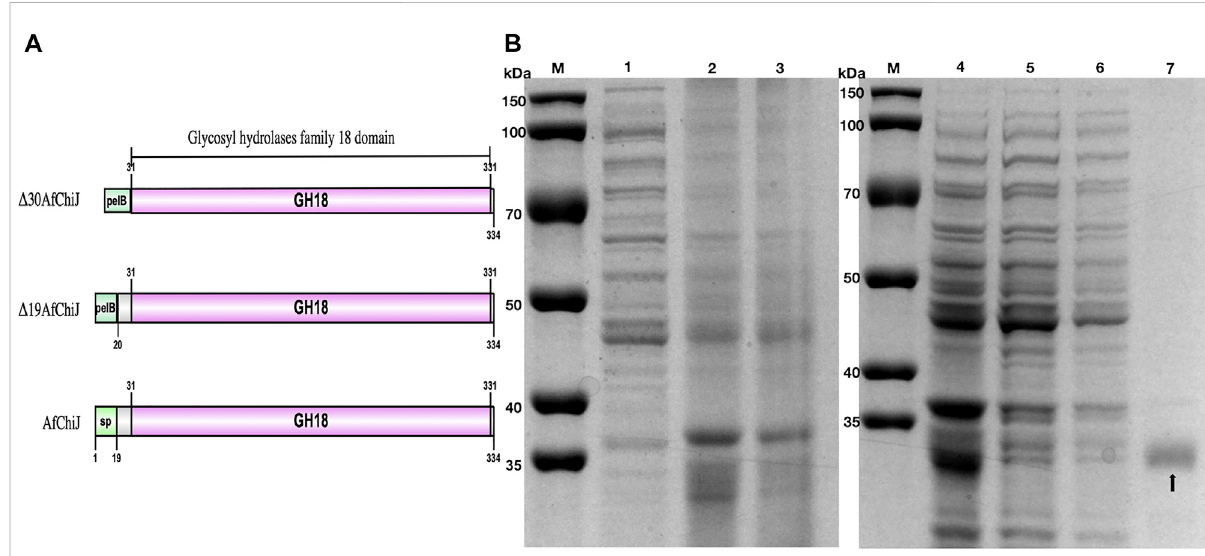
FIGURE 2 Schematic structure domains and SDS-PAGE analysis of chitinase Δ 30 Af ChiJ. (A) Schematic structure domains of Af ChiJ and its N-terminal truncation variants, Δ 19 Af ChiJ and Δ 30 Af ChiJ use signal peptide of pelB from pET-22b (+). (B) SDS-PAGE analysis of the puri fi ed chitinase Δ 30 Af ChiJ. M, protein molecular weight markers; 1, crude extract of E. coli BL21 (DE 3 )/pET-22b; 2, crude extract of E. coli BL21 (DE 3 )/pET-22b- Δ 30 Af ChiJ; 4, supernatant of E. coli BL21 (DE Δ 30 Af ChiJ; 5, Δ 30 Af ChiJ; 3, supernatant of E. coli BL21 (DE 3 )/pET-22b- 3 )/pET-22b-